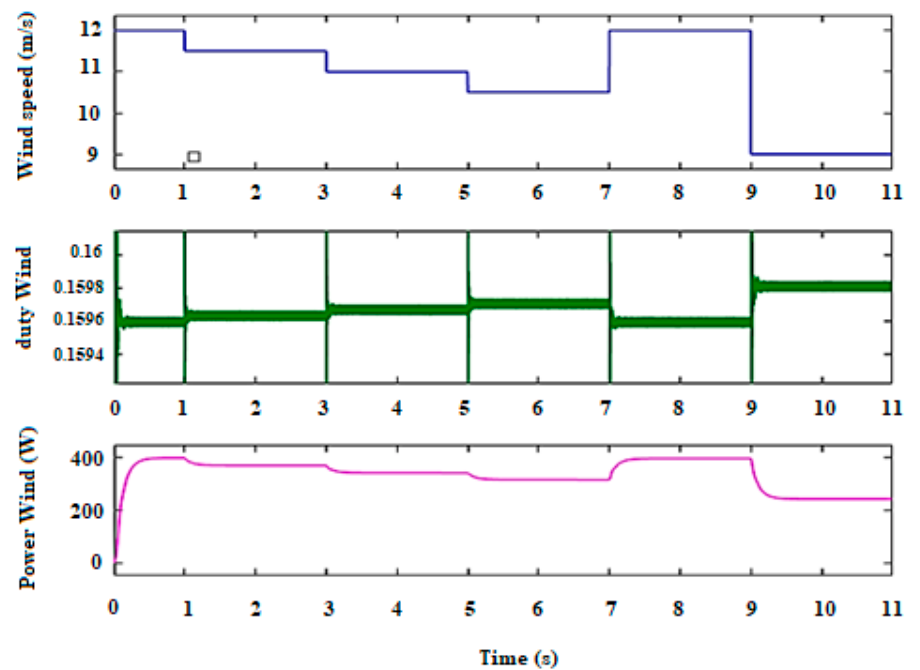
Figure 11. Waveforms of wind speed, duty cycle, and output power of the WTG.